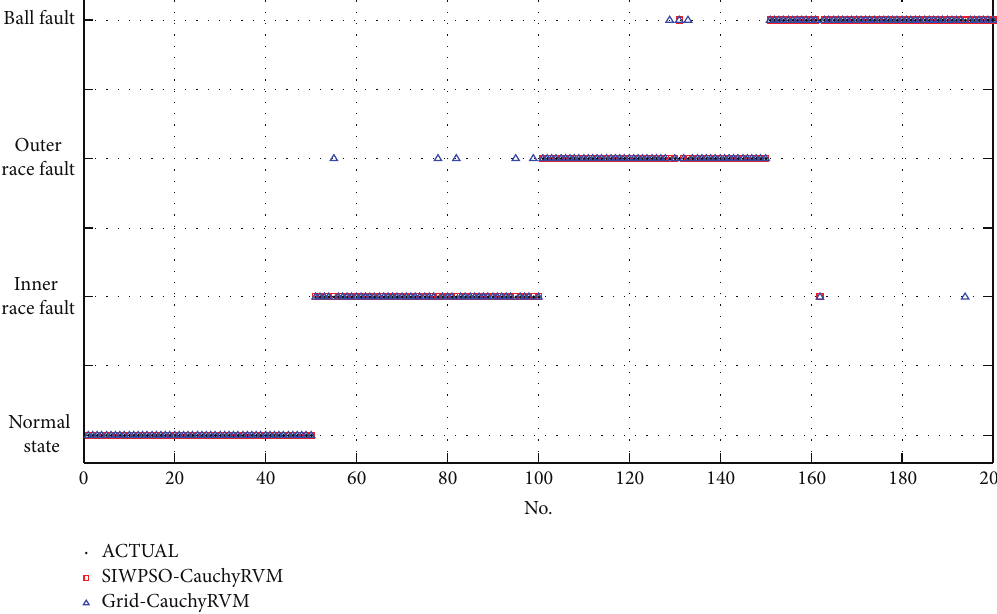
range of the Cauchy kernel parameter 𝑞 is between 0 and 2, and the minimum interval of the Cauchy kernel parameter 𝑞 is